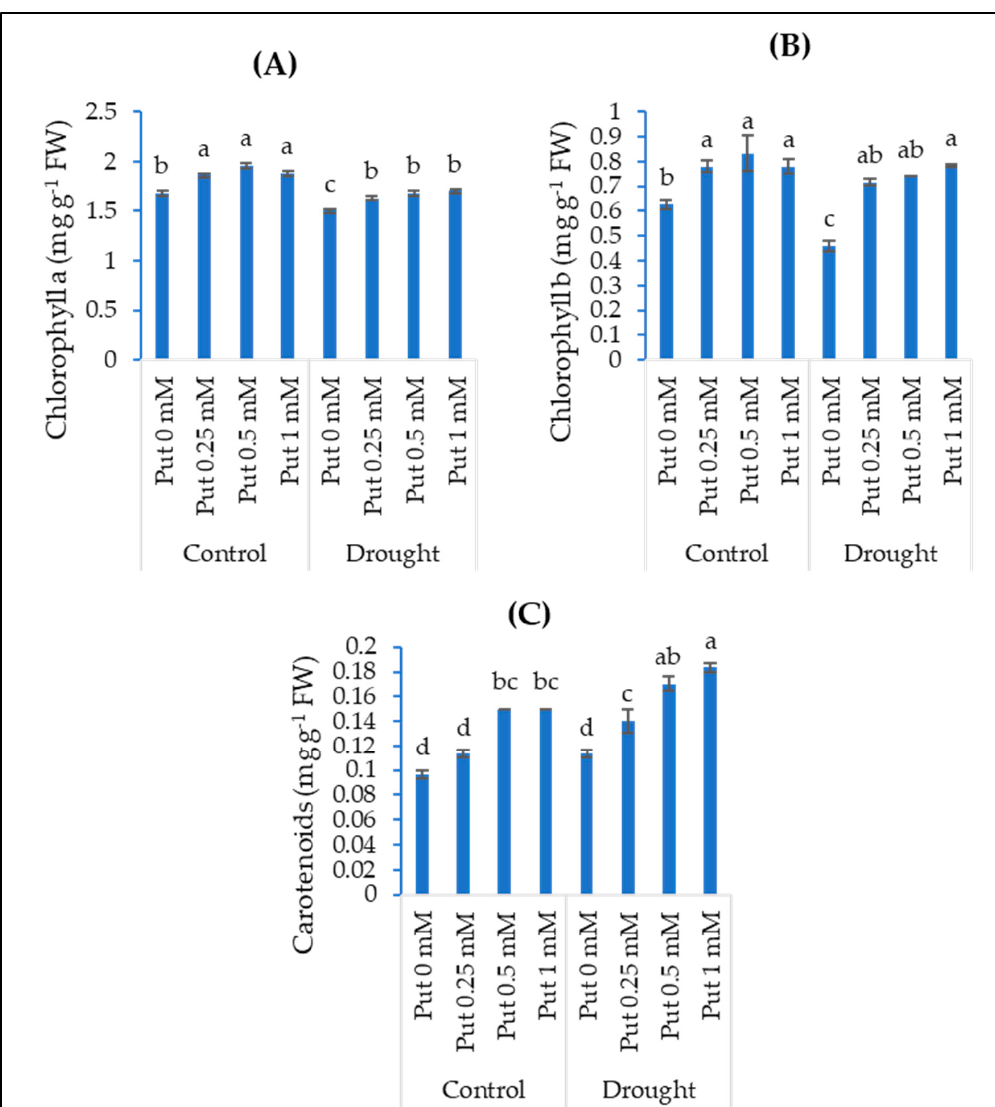
Figure 1. Change of chlorophyll a ( A ), chlorophyll b ( B ), and carotenoids ( C ) contents in wheat plants pretreated with putrescine, drought stressor, and their combination. Each bar shows mean ± standard error. Different letters indicate different significance between means.